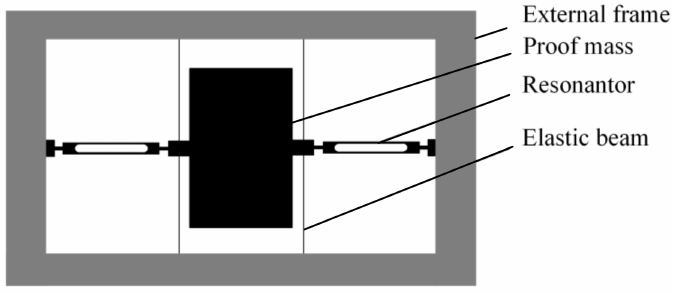
Figure 1. Schematic of the resonant